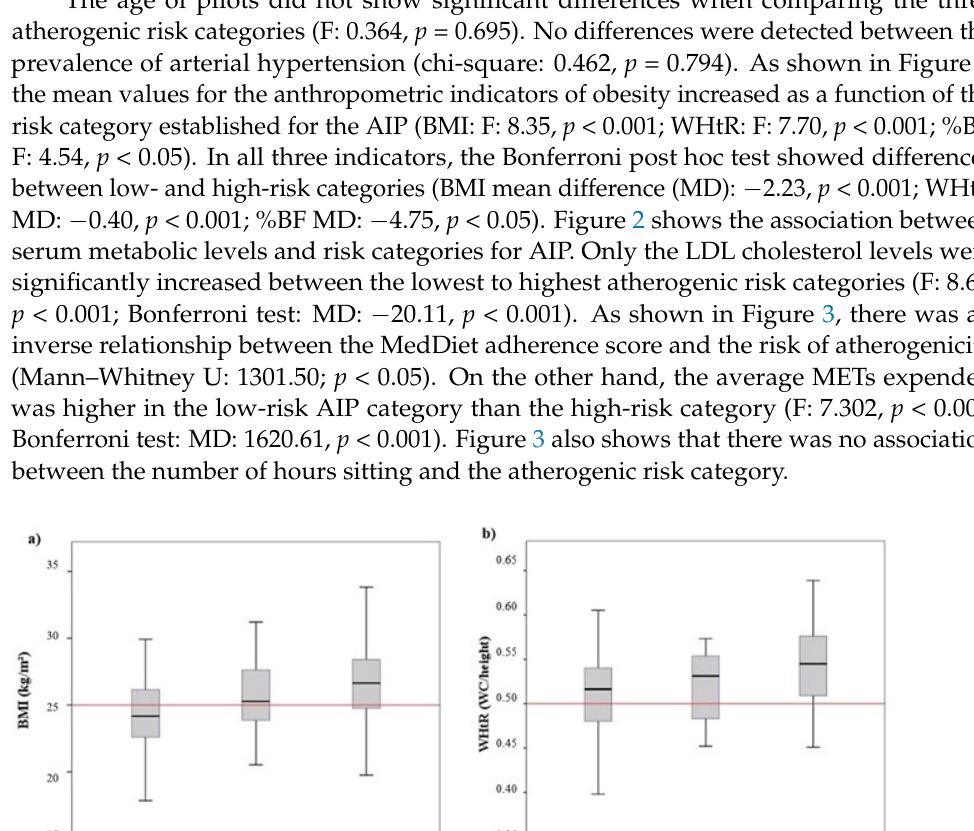
Figure 2. Boxplots of ( a ) glucose, ( b ) total cholesterol and ( c ) cholesterol-LDL, according to the different levels of AIP.